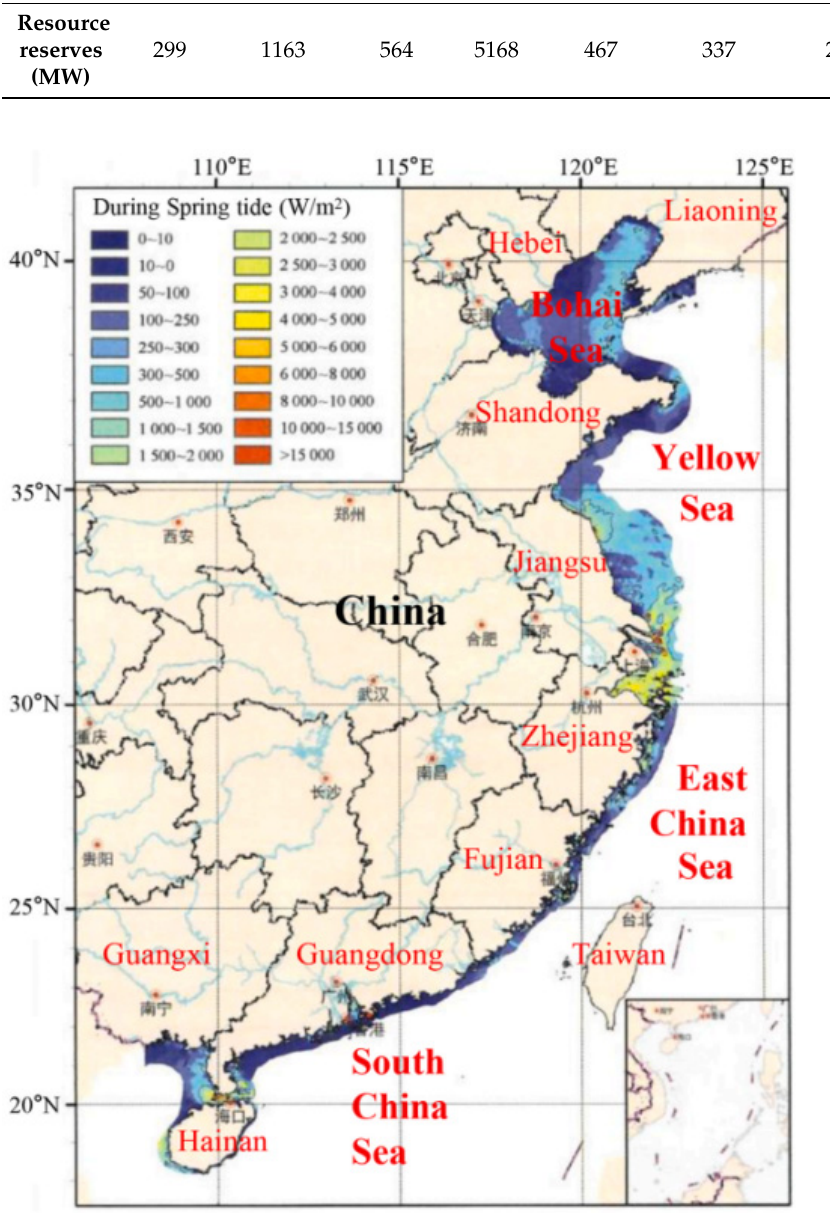
Figure 1. Average power density distribution during spring tide in 2004 national resource assessment. Reproduced from [11], Elsevier.